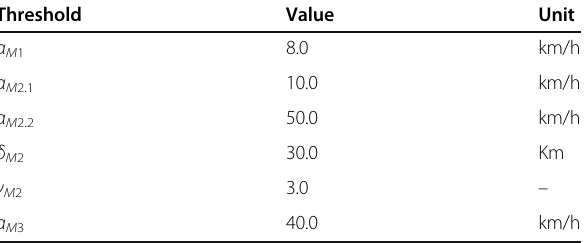
Table 2 parameter threshold values used in pre processing Threshold